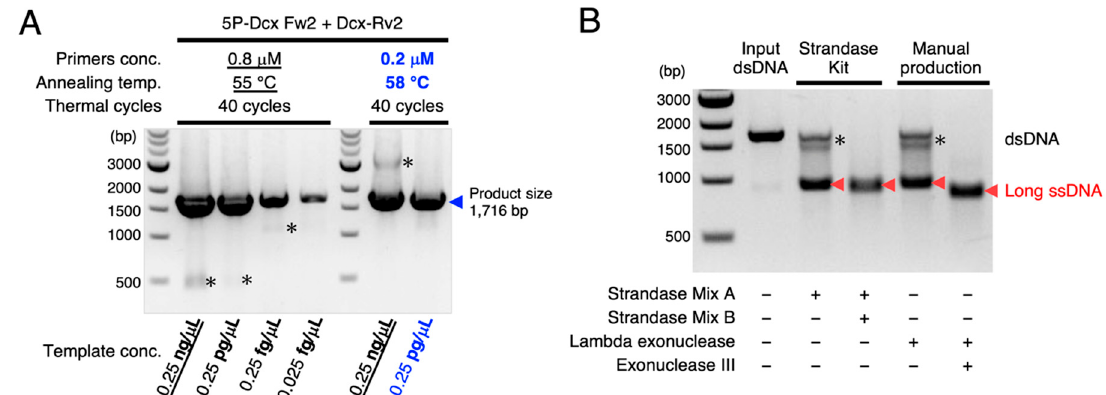
Figure 3. Purely amplified PCR products and the following sequential use of two exonucleases enabled high-quality ssDNA production. ( A ) Optimization of PCR conditions to obtain a clear single product was the first key step for phospho-PCR-mediated ssDNA production. Primers’ concentrations, annealing temperature, and templates’ concentration for the PCR reaction depicted in Figure 2B were optimized. The manufacturer’s protocols are underlined, and our optimized conditions are colored in blue. To obtain a single product with high efficiency, the primers’ concentrations should be lower, the annealing temperature should be higher, and the templates’ concentration should be much lower than the manufacturer’s instructions. Asterisks (*) indicate the unwanted non-specific amplifications. Blue triangle indicates the purely amplified products. ( B ) Sequential use of two exonucleases depicted in Figure 2B allowed for highly pure long ssDNA production. While the single use of Strandase Mix A or Lambda exonuclease selectively degraded 5 ′ -phosphorylated strands to yield ssDNAs (red triangles), dsDNA substrates indicated by asterisks remained in the reaction mixtures. Subsequently added Strandase Mix B or Exonuclease III degraded the remaining dsDNAs to yield pure long ssDNAs. Note that the long ssDNA treated with Exonuclease III was slightly shorter than that treated with Strandase Mix B.